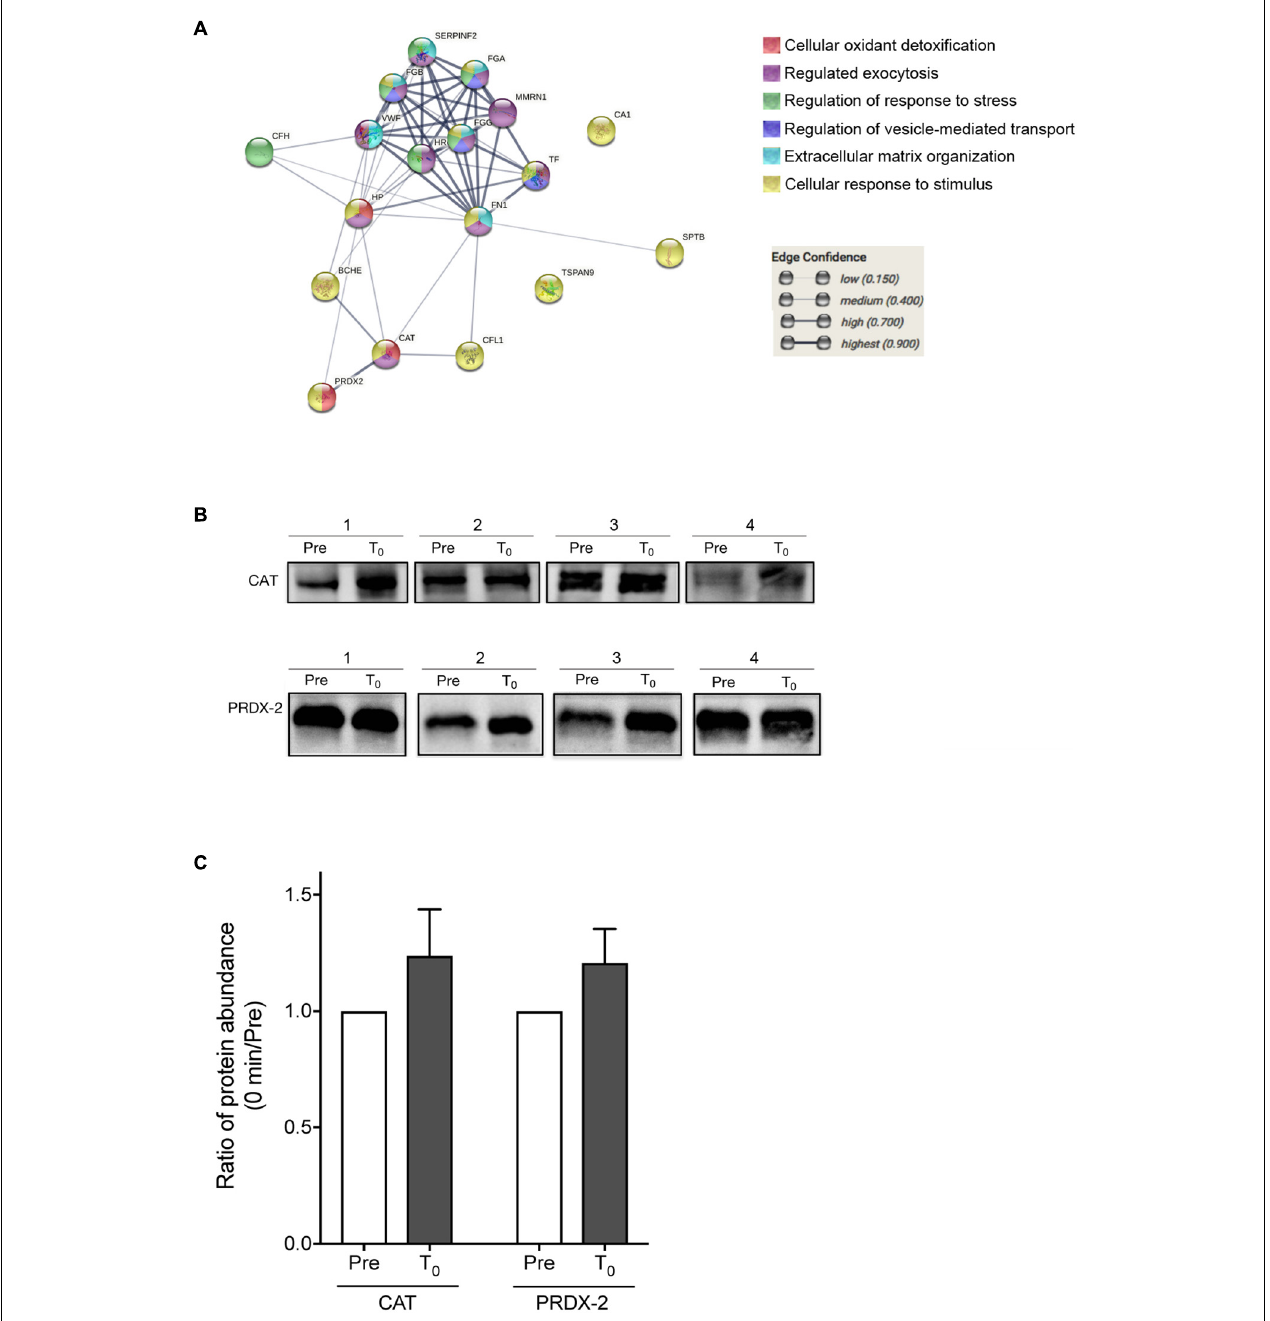
FIGURE 5 | Proteomics analysis of EV proteins. (A) Proteomics analysis was performed on the EV proteins changed among at pre-HIIT-Ex, T 0 , and T 30 . (B) Representative immunoblotting of CAT and PRDX-2 in circulating EVs before (pre) and at T 0 . (C) Abundance ratio of EV protein expression, CAT and PRDX-2, in circulating EVs at T 0 compared to pre-HIIT-EX, which was quantified using Multi Gauge software. Pre: